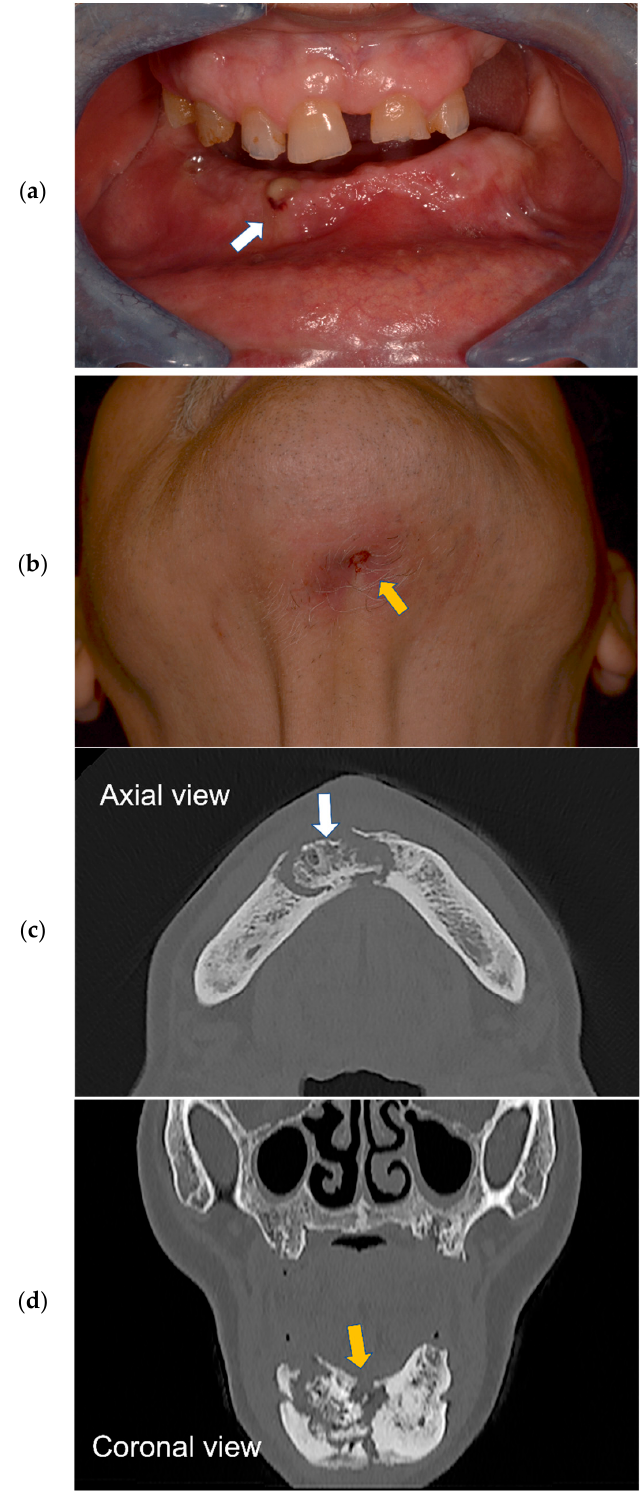
Figure 3. Stage 3 according to SICMF-SIPMO staging system: complicated MRONJ. ( a , b ) Probing bone fistula and suppuration without frank bone exposure of the mandible in the oral cavity (white arrow); extraoral cutaneous fistula of the submental region (yellow arrow). ( c , d ) CT scan axial view showing increased bone density (diffuse bone condensation and osteosclerosis) of the entire mandibular arch with massive sequester formation (white arrow); in the coronal view, pathologic fracture of the mandibular symphysis is clearly visible (yellow arrow).